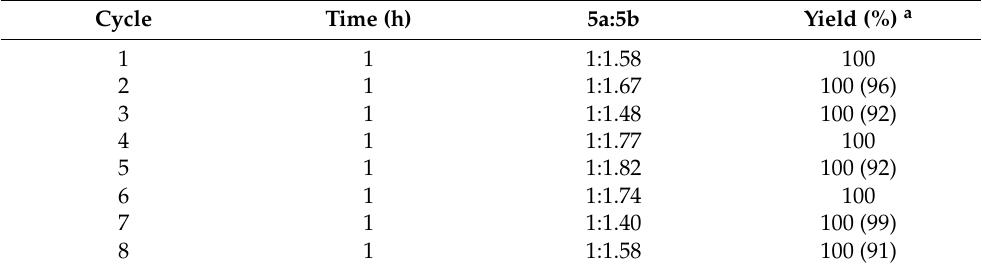
Table 3. Hydrosilylation reaction of 1-decyne ( 5 ) and triethylsilane ( 3 ) under thermomorphic condition. Cycle